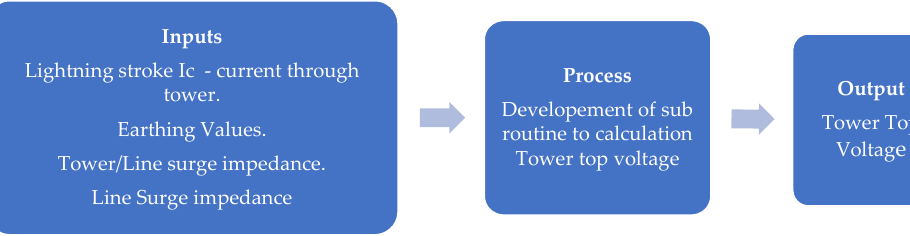
Figure 6. Process to determine the Tower Top Voltage.